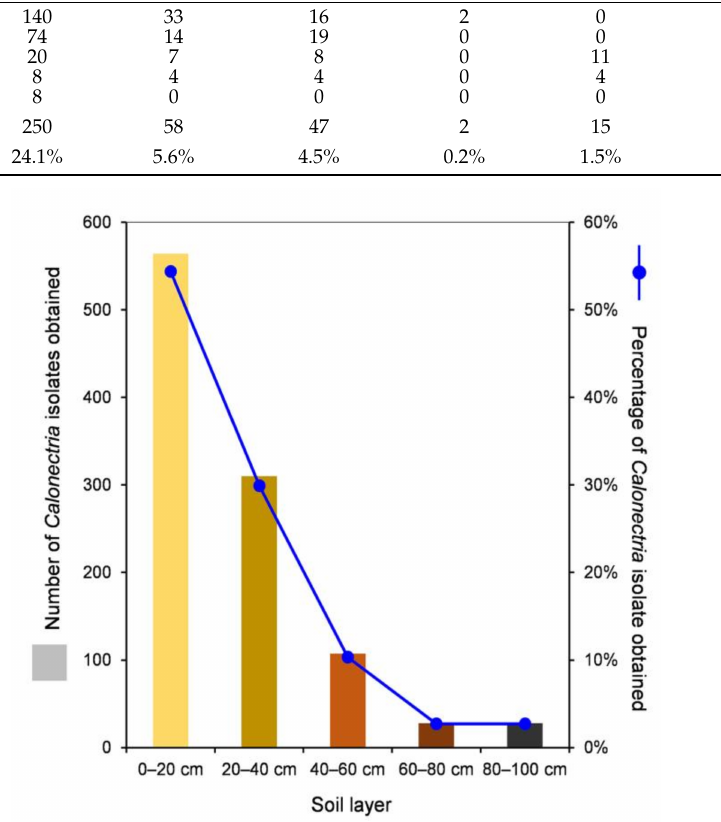
Figure 1. Numbers and percentages of Calonectria isolates obtained in each of the five soil